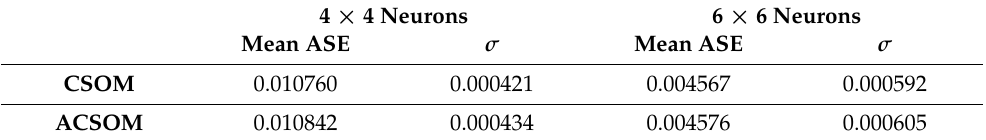
Table 3. CSOM and ACSOM mean ASE and standard deviation comparison over 50 tests. 4 × 4 Neurons 6 × 6 Neurons